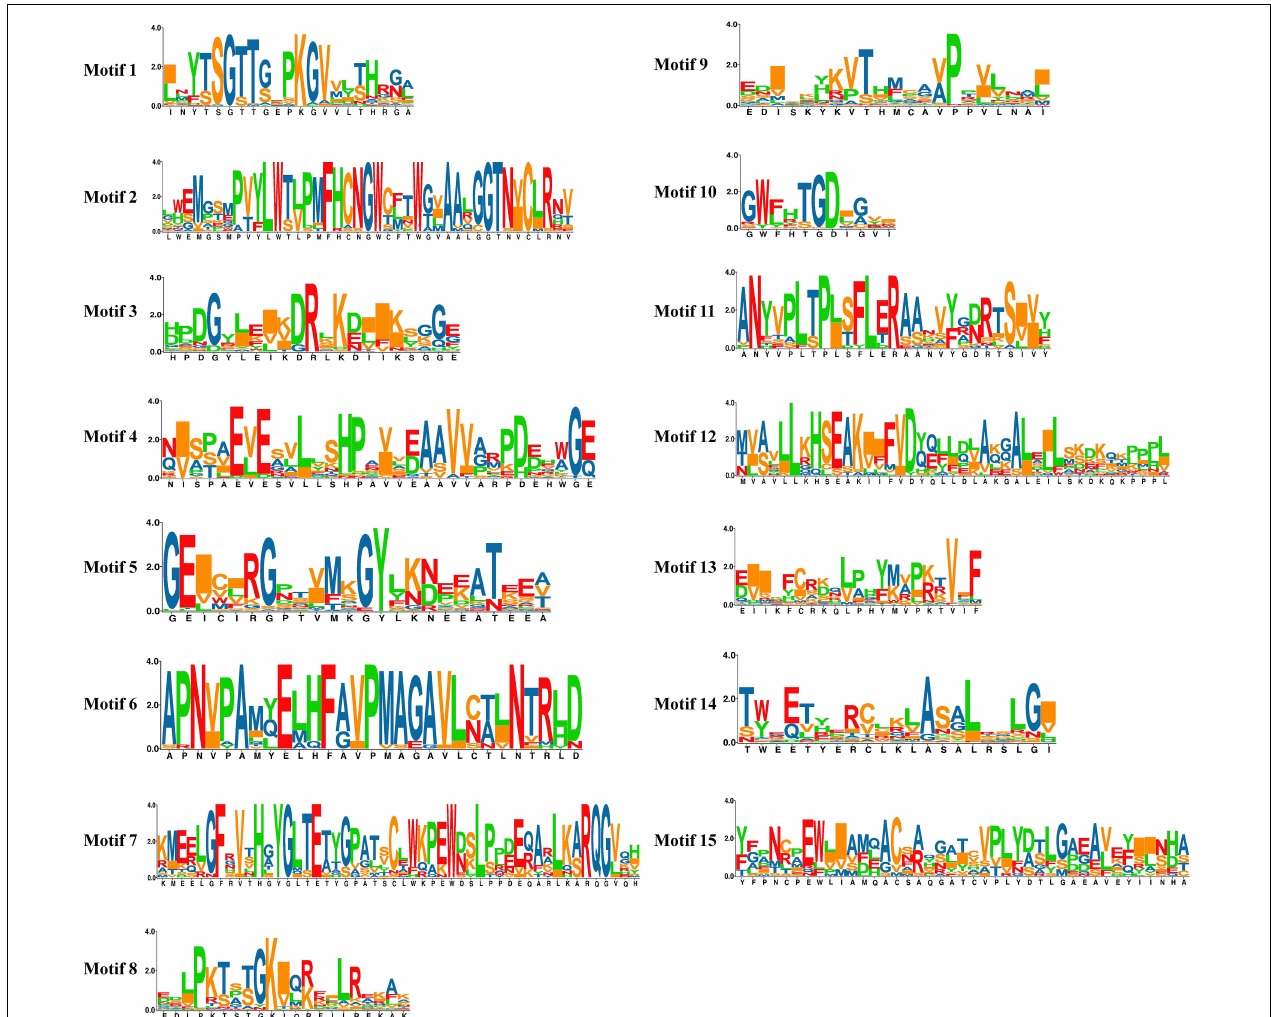
FIGURE 4 | The sequence information of each conserved motif (1–15). Conserved motifs of acyl-activating enzyme (AAE) superfamily members were found using the MEME online tool with parameters: number of repetitions (any), maximum number of motif (20), and the optimum width of each motif (between 6 and 100 residues).